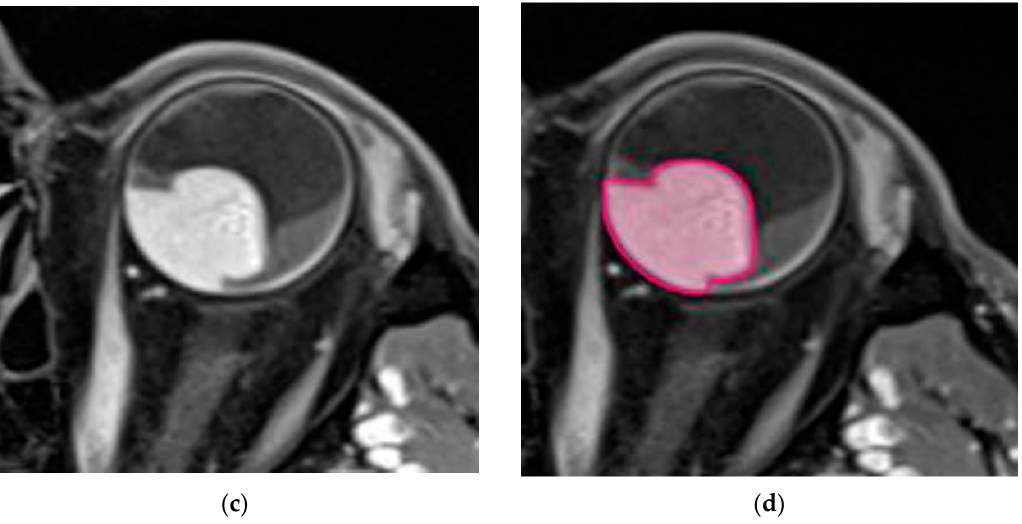
Figure 2. ( a ) Highly prominent choroidal ciliary body melanoma, axial plane, MR T2 ciss sequence, 0.5 mm. ( b ) Highly prominent choroidal ciliary body melanoma, axial plane, MR T2 ciss sequence, 0.5 mm, definition of the uveal melanoma. ( c ) Highly prominent choroidal melanoma, axial plane, MR T1 TSE sequence, bilateral retinal detachment. ( d ) Highly prominent choroidal melanoma, axial plane, MR T1 TSE sequence, bilateral retinal detachment, gross tumor volume (GTV) definition.